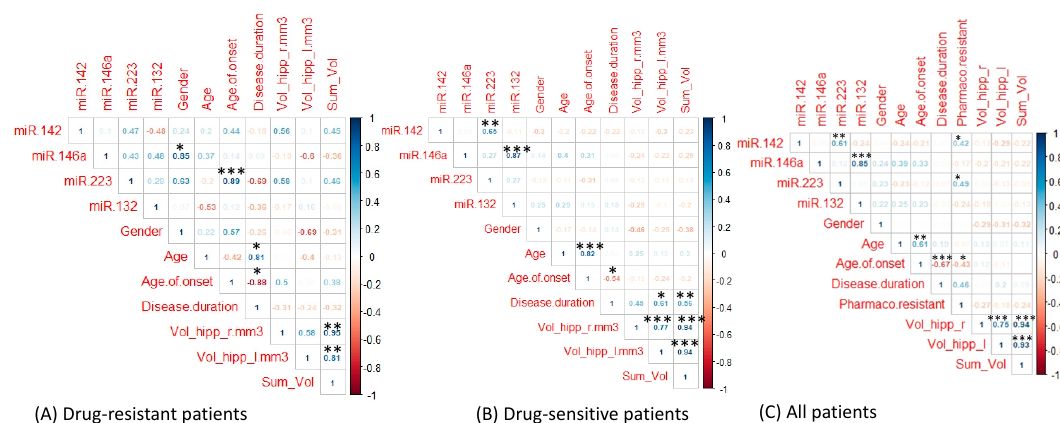
Figure 3. Correlation matrix in ( A ) drug-resistant patients, ( B ) drug-responsive patients, and ( C ) all patients. Positive correlations are visualized in blue color and negative correlations in red color. Color intensity of the text labels is proportional to the correlation coefficients. Significant p-values corresponding to the correlation coefficient are indicated with asterisk (* p -value < 0.05; ** p -value < 0.01; *** p -value < 0.001).